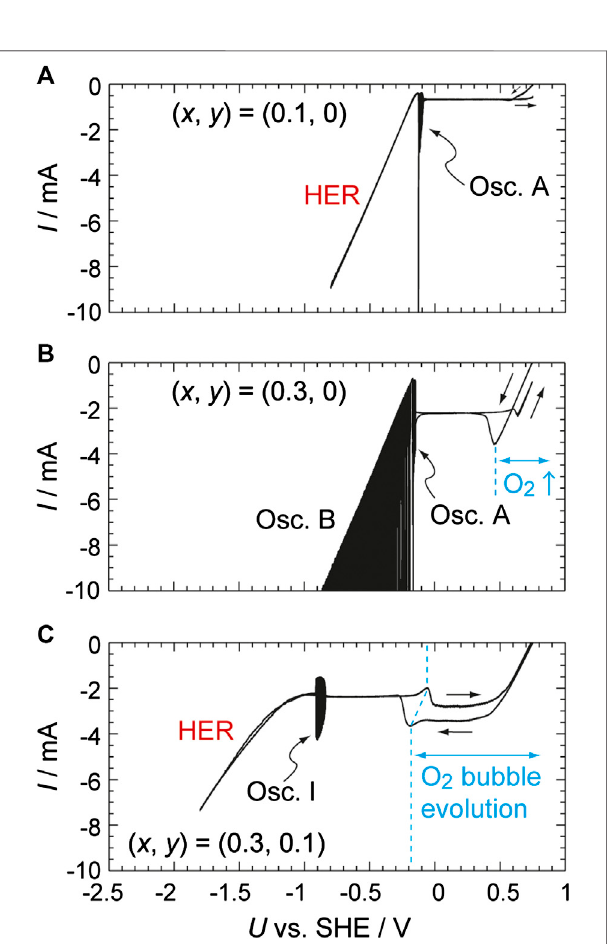
FIGURE 2 | I – U curves obtained using a Pt disc electrode (2 mm in diameter) in 0.1 M H 2 SO 4 + x M H 2 O 2 + y M Na 2 SO 4 , where ( x , y ) (cid:2) (0.1, 0) (0.3, 0) and (0.3, 0.1) going from top to bottom, under controlled potential conditions at a sweep rate of 0.01 V s − 1 .